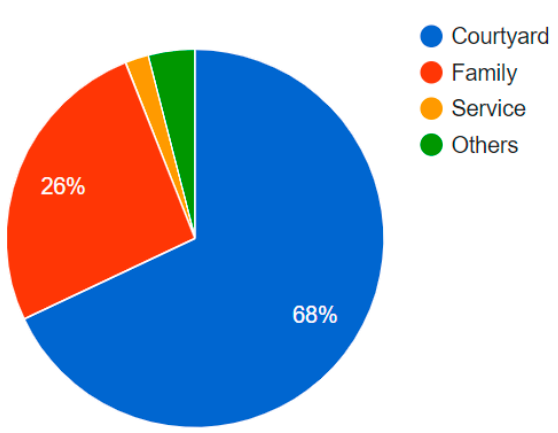
Figure 9. The percentages of the functional units of the residential buildings.